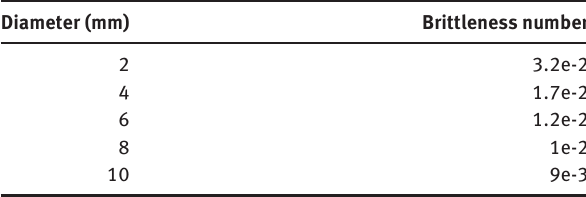
Table 13 Test results for [0/45/90]